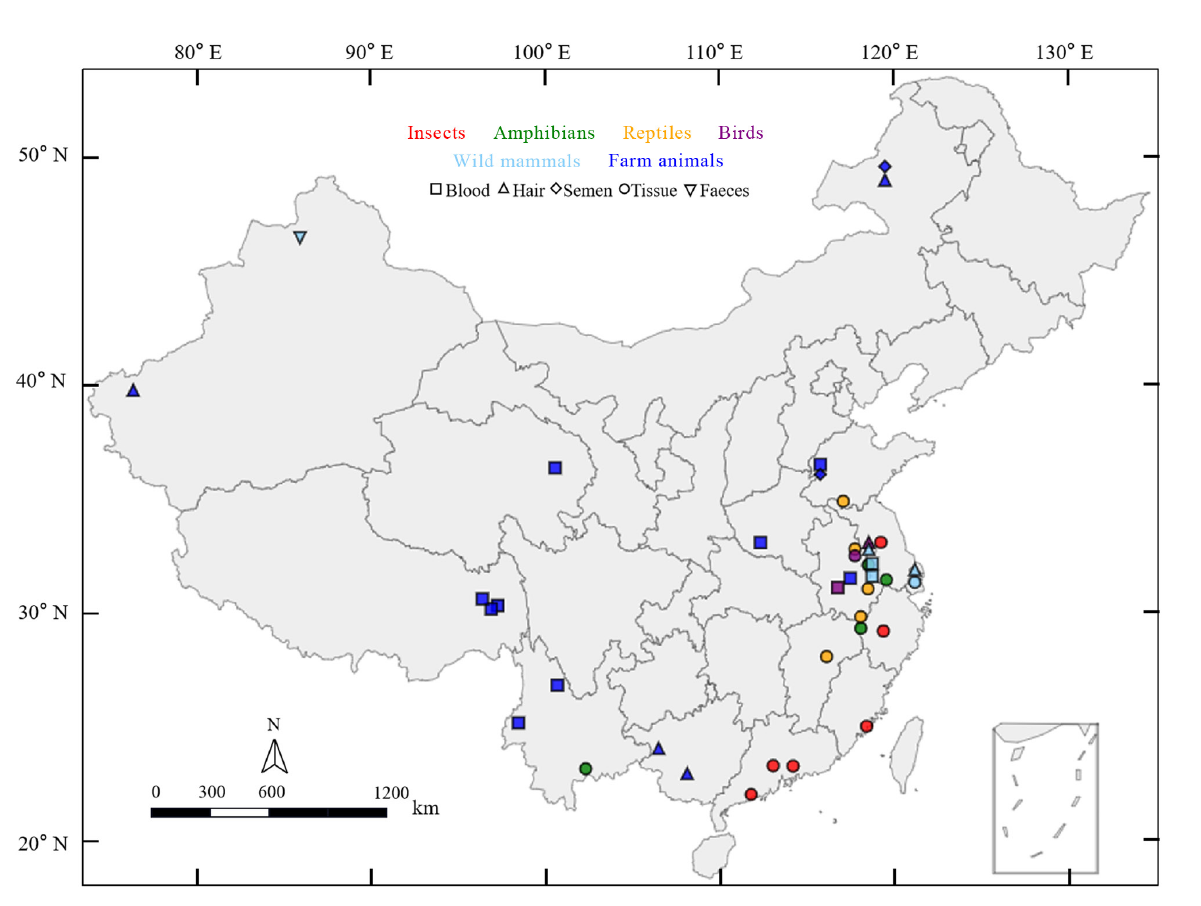
Figure 1. Map of China with sampling sites indicated according to the classification and properties of the specimens. Detailed sample information is shown in Table S1.